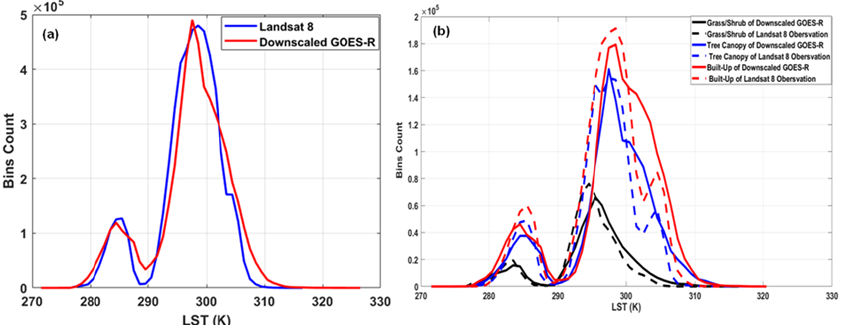
Figure 7. Comparison of histograms of LST from SDM and Landsat–8 over New York City for ( a ) all cases, and ( b ) different land cover types.